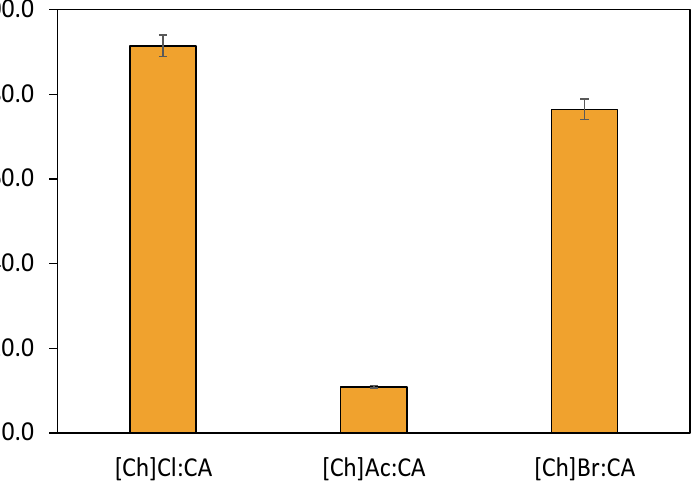
Figure 3. 5-HMF yields attained for different cholinium-based HBA at 120 °C, 2 min of reaction and S/L ratio of 0.05.